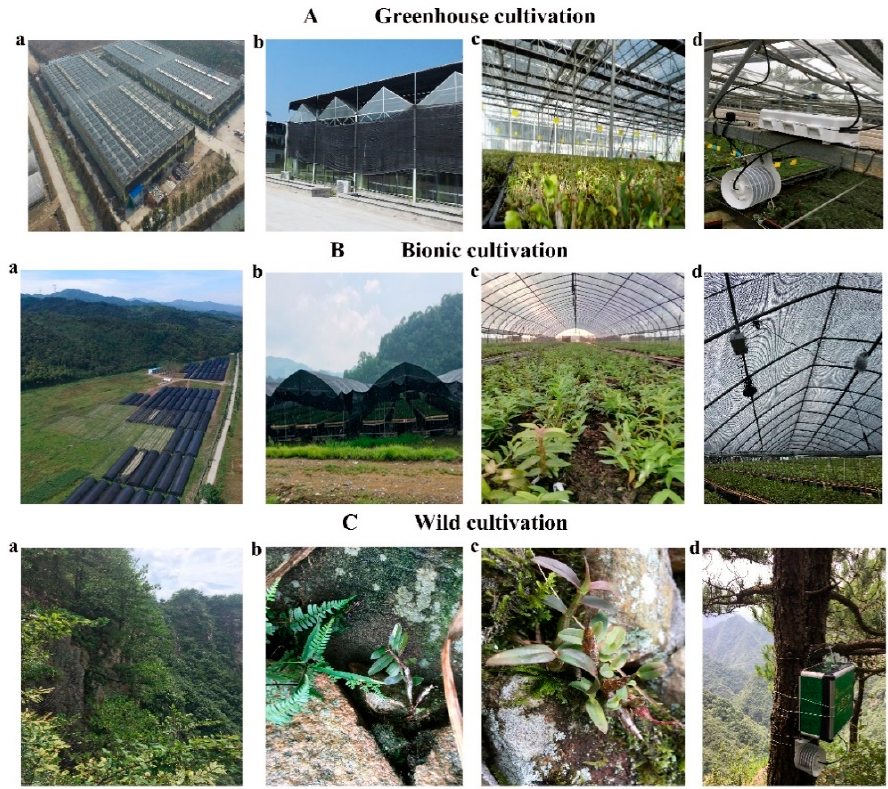
Figure 2. Different cultivation modes of Dendrobium officinale . ( A ) Greenhouse cultivation mode. ( a – c ) The growth environment of Dendrobium officinale in the greenhouse cultivation mode. ( d ) The position where the EM50 instrument (Decagon Devices Inc., Pullman, WA, USA) is placed in the greenhouse. ( B ) Bionic cultivation mode. ( a – c ) The growth environment of Dendrobium officinale in the